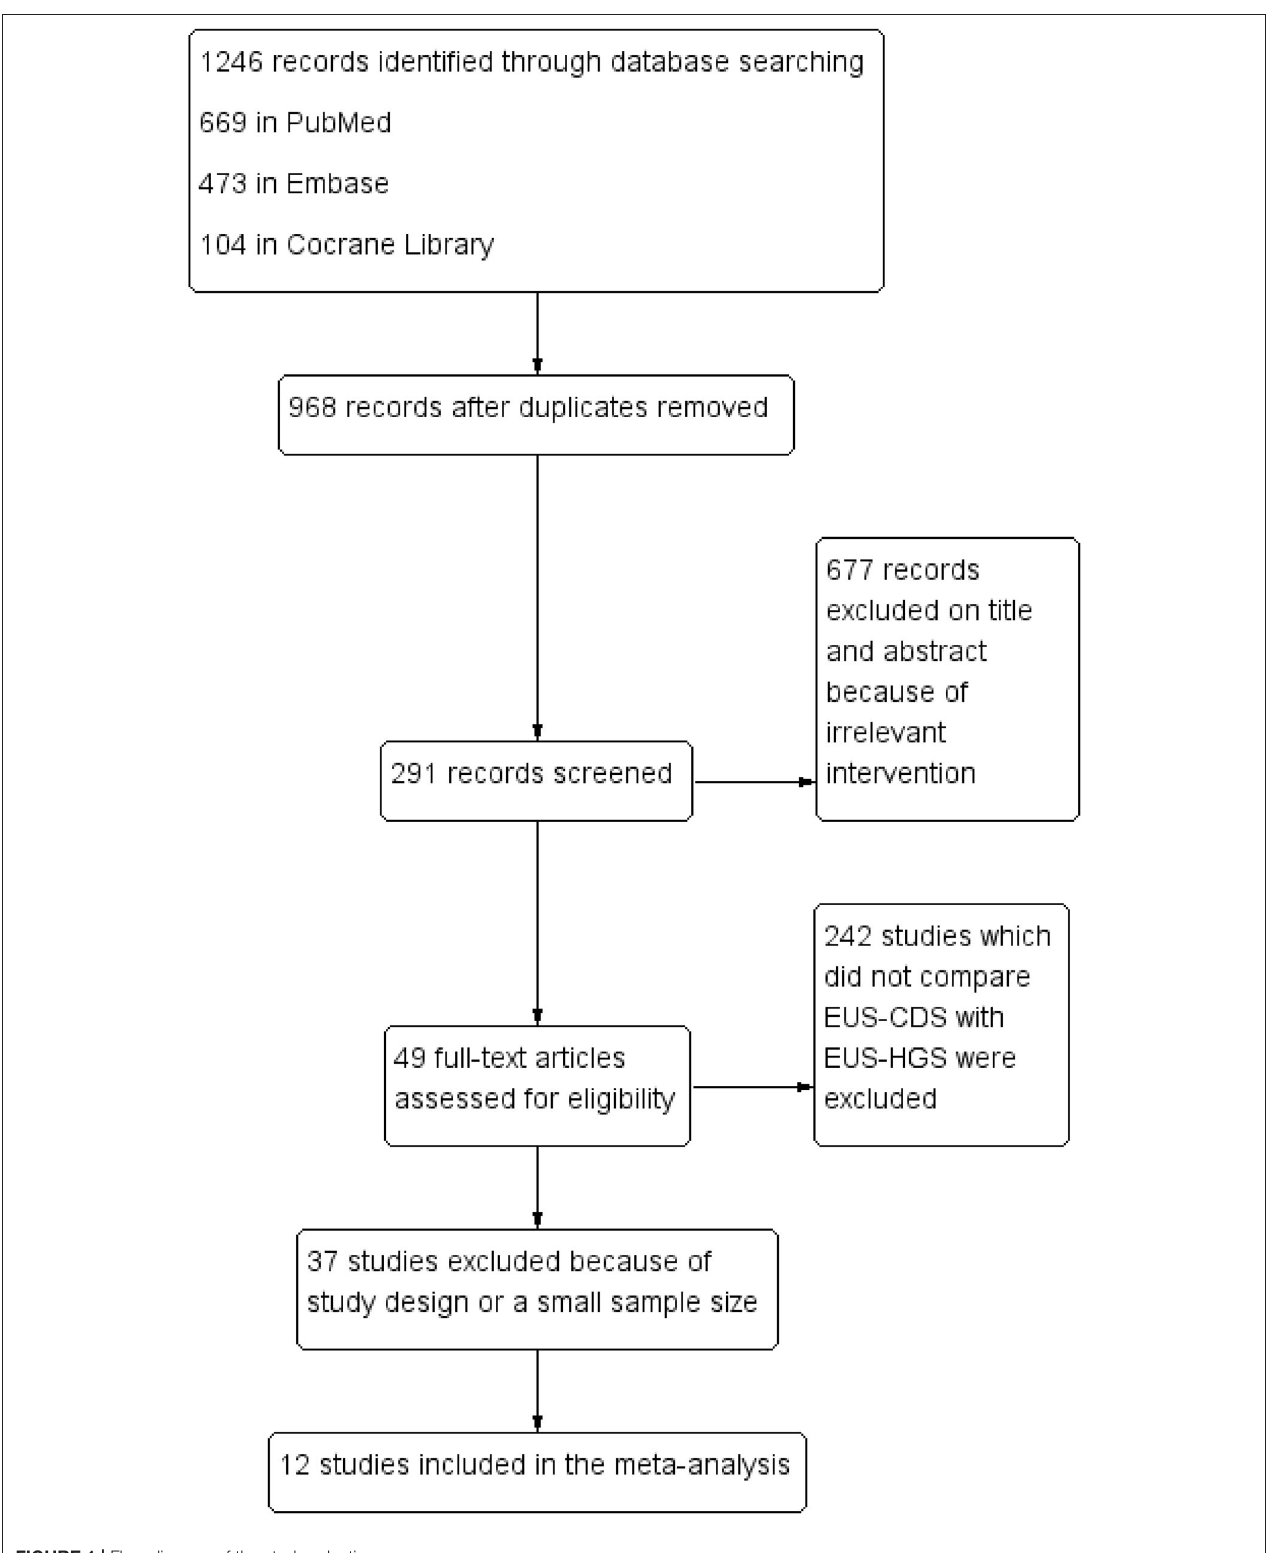
FIGURE 1 | Flow diagram of the study selection process.